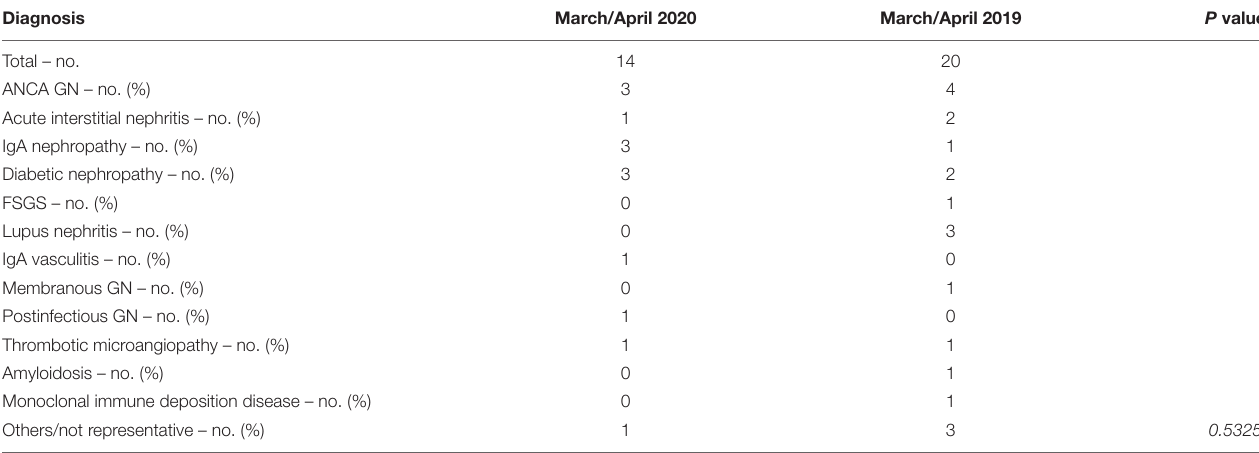
TABLE 5 | Diagnoses of kidney diseases based on renal biopsies comparing the COVID-19 lockdown period 2020 with the same period in 2019. Diagnosis